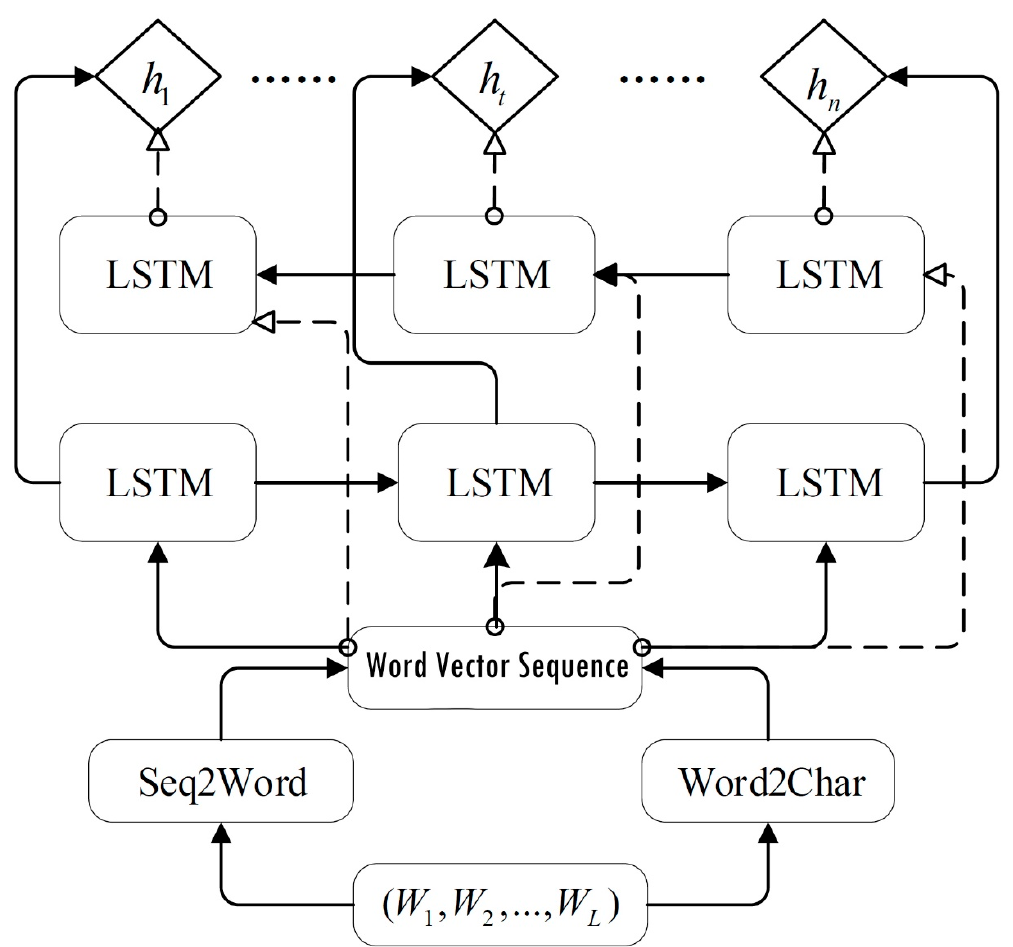
Figure 3. Network structure diagram of the embedded layer.